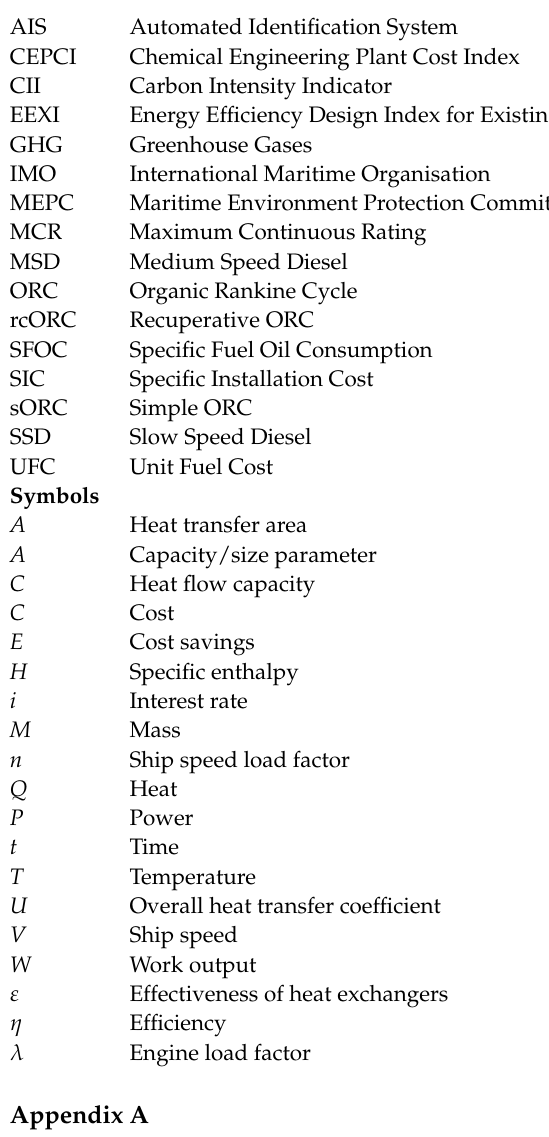
Table A1. List of Reported Maritime Applications of